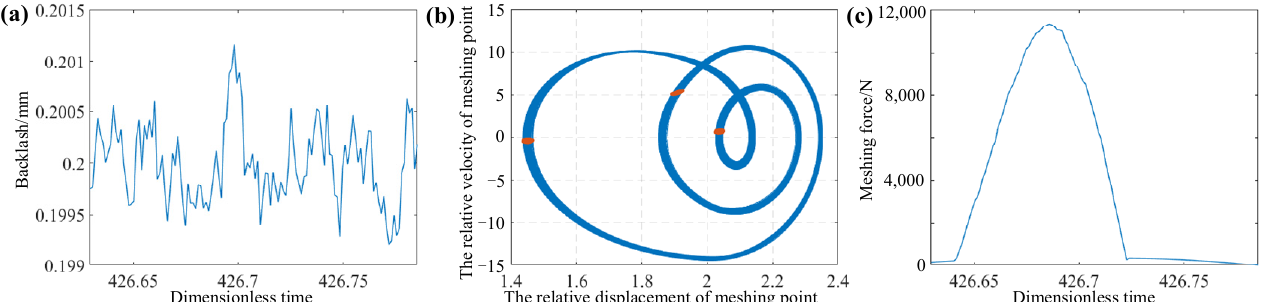
Figure 5. System response and meshing force with D = 1.6. ( a ) Backlash with fractal characteristics. ( b ) Phase diagram and Poincare section diagram. ( c ) Meshing force.